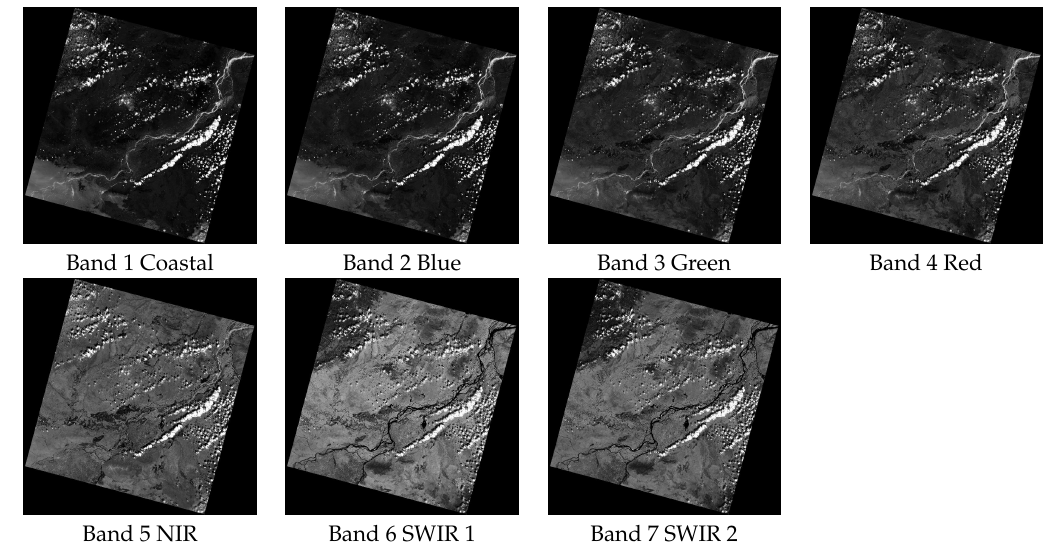
Figure 4. Visualization for seven-band Landsat 8 OLI imageries (Path 113, Row 26). In our experiments, all seven bands were exploited as default